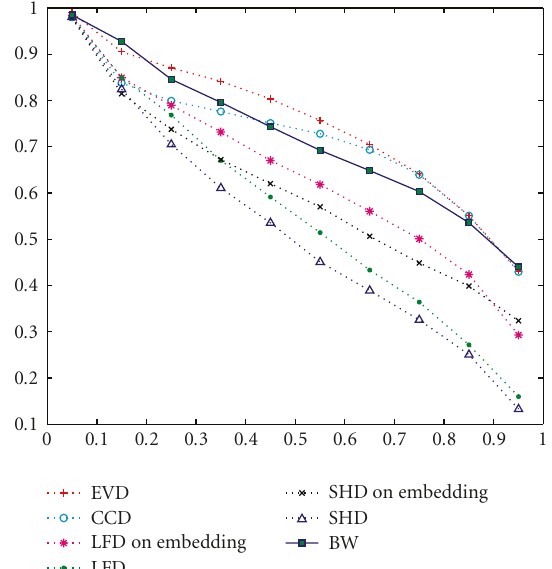
Figure 7: Precision-recall (PR) plots for various descriptors when applied to the McGill database of articulated shapes [19]. Except BWs, all of the other results can be found in